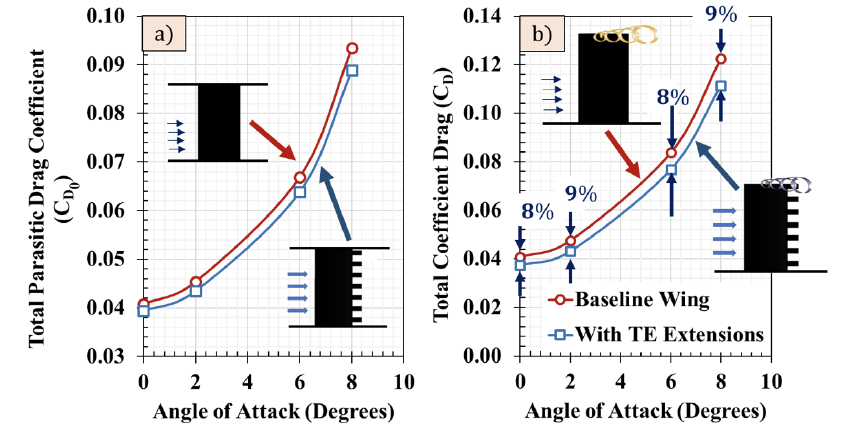
Figure 14. Variation of ( a ) net parasitic drag coefficient and ( b ) the total drag coefficient of the baseline wing and wing with TE extensions. The wing with TE extensions shows an average decrease in the drag coefficient around 8%.